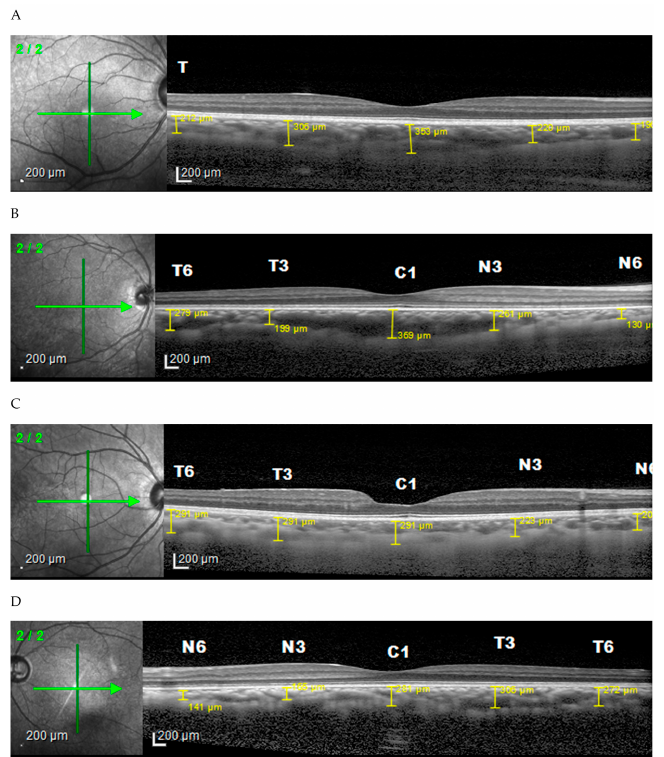
Figure 1. Choroidal thickness based on degrees of myopia horizontally. ( A ) Normal subject, ( B ) low myopia, ( C ) moderate myopia, ( D ) high myopia.